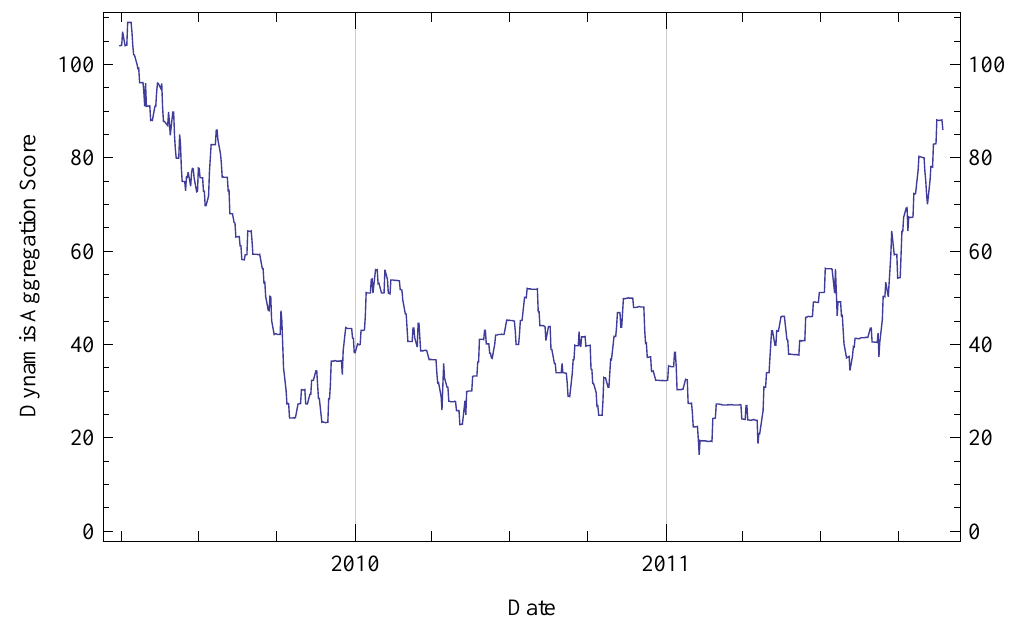
Figure 5. INTC score computed daily using Dynamis with the following scoring